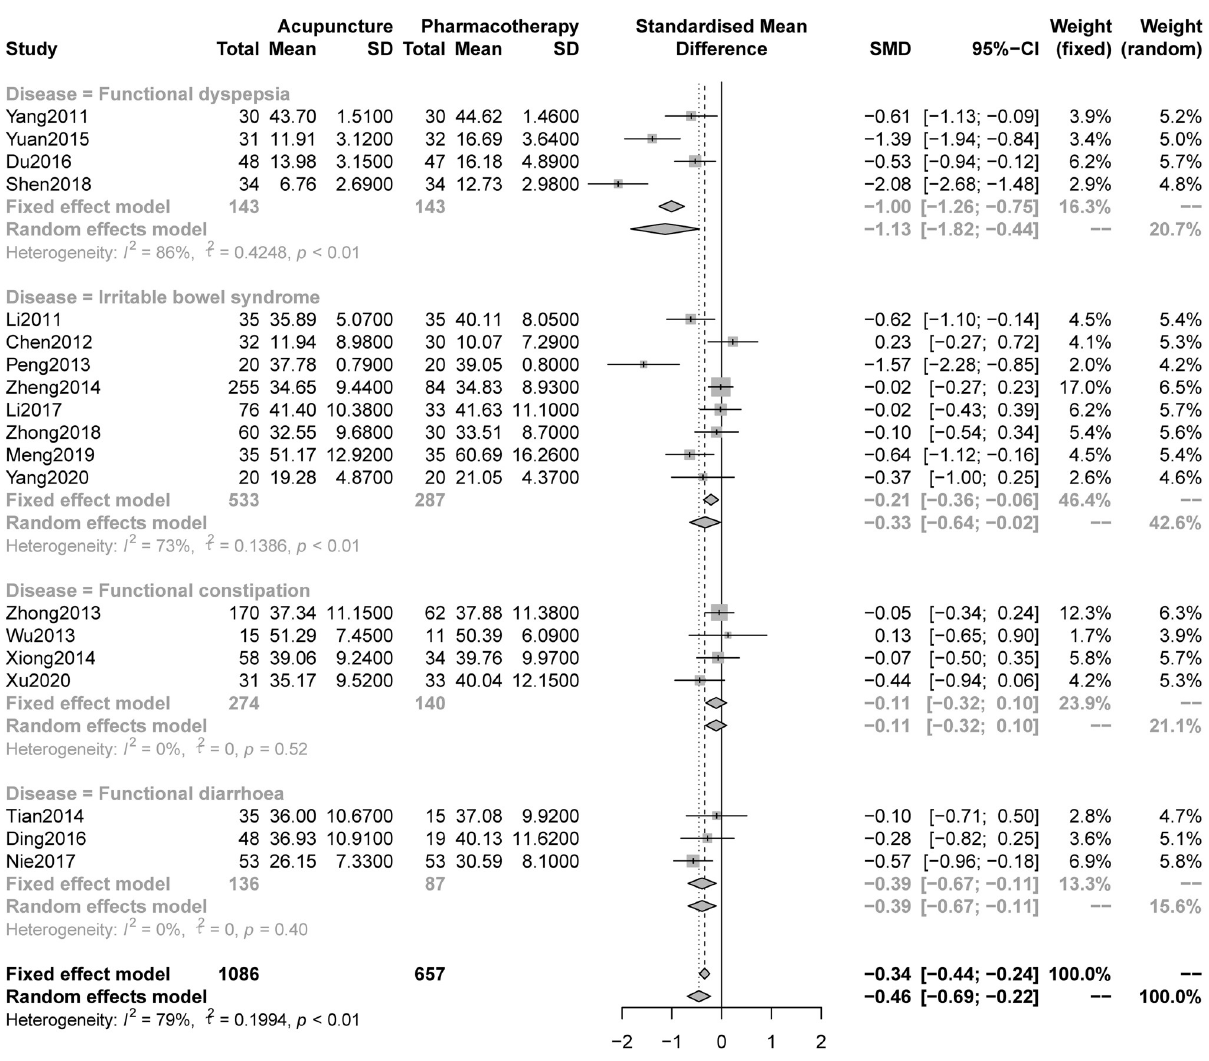
Fig 4. Forest plot of comparison: Acupuncture versus pharmacotherapy, outcome: Severity of depression at the end of treatment.